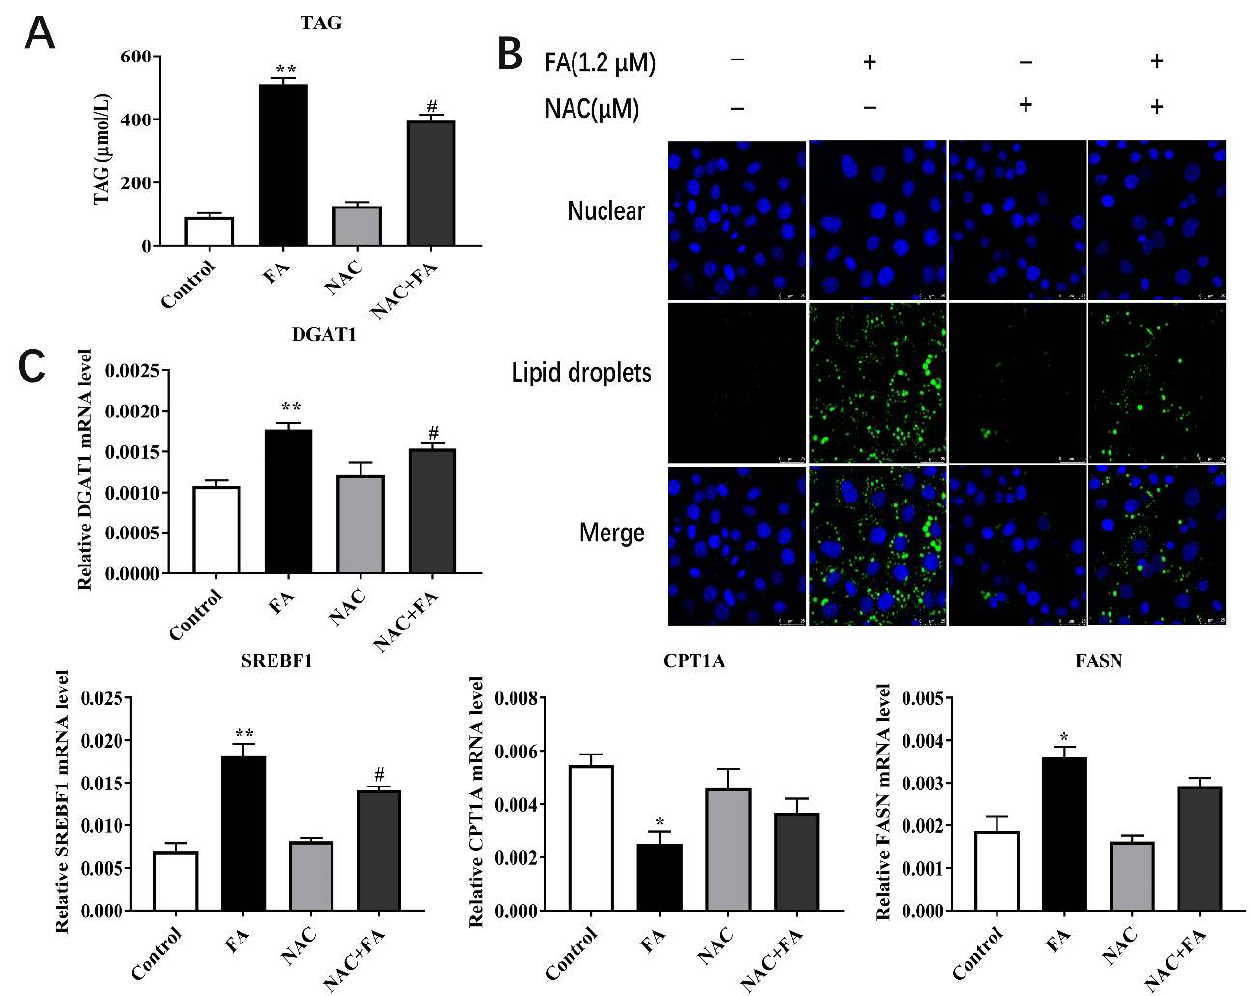
Figure 5. The effect of NAC on TAG concentration, lipid droplet immunofluorescence, key mRNA associated with lipid synthesis, FA oxidation in primary calf hepatocytes. Hepatocytes were treated with 10 mM NAC or RPMI-1640 basic medium (Control) with or without 1.2 mM FA. ( A ) TAG content in hepatocytes. ( B ) Immunofluorescence results of lipid droplets, scale bar = 25 µ m. ( C ) Relative mRNA abundance of DGAT1, SREBP-1C, CPT1A, and FASN. Data were analyzed using a two-way repeated-measure (RM) ANOVA with subsequent Bonferroni correction. The data presented are the means ± SEM; * p < 0.05, ** p < 0.01 indicate differences from the control. # p < 0.05 indicate differences from cells incubated with FA.